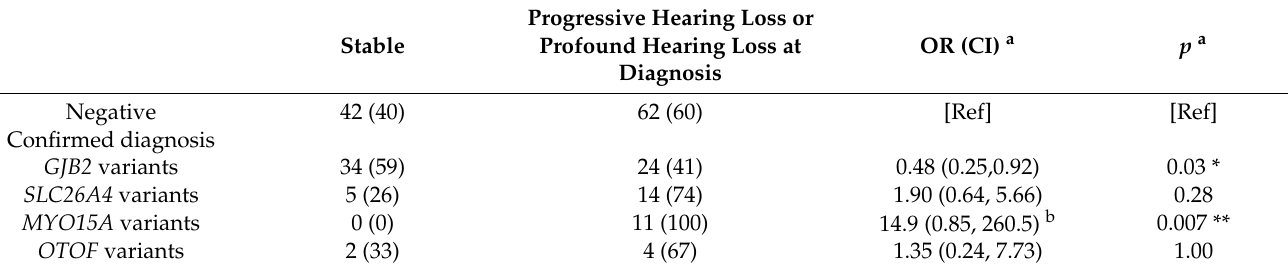
Table 5. Prognosis of hearing in patients with different genetic diagnoses.